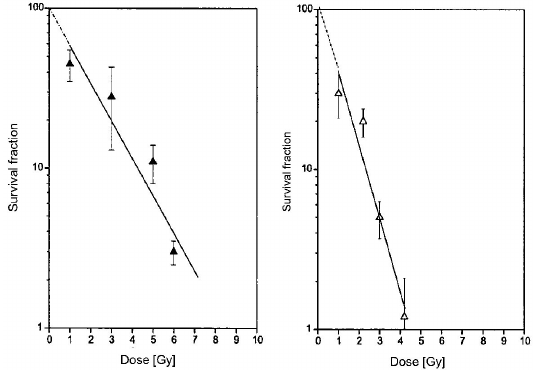
Figure 3. Pigmented cells were more resistant to X-rays than unpigmented Ab cells. The cells were irradiated in vitro, and immediately after implanted subcutaneously into hamsters, always using the same number of cells (10 6 ). The average rate of tumor growth was determined for each dose, and the survival fraction of irradiated cells was calculated from a set of tumor growth curves, where the tumor was initiated with various cell numbers [129]. Copyright 1984 Gurbiel,